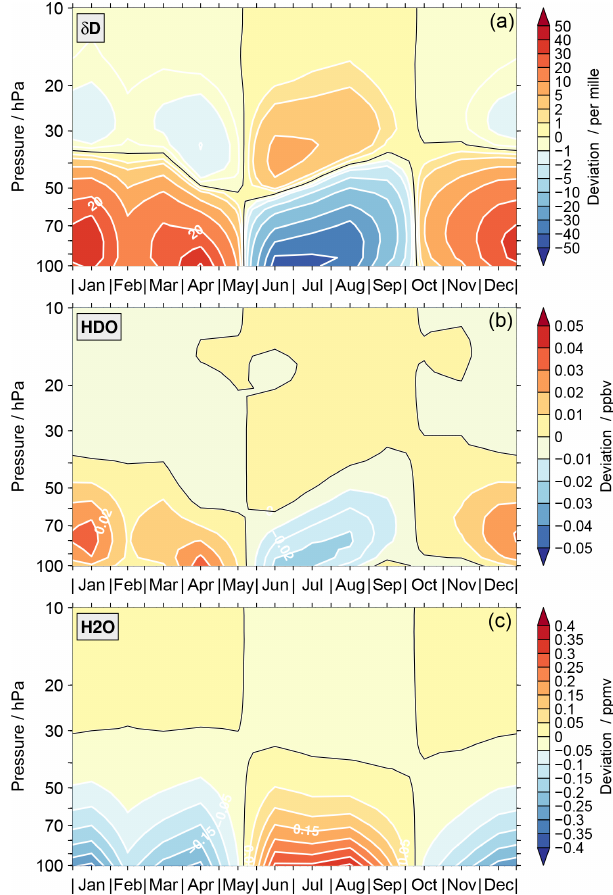
Figure 8. The approximated impact of the start altitude effect, in combination with temporal variation of the start altitude, on the an- nual variation of δ D (a) , HDO (b) and H 2 O (c) calculated using Eq. (A15) in the